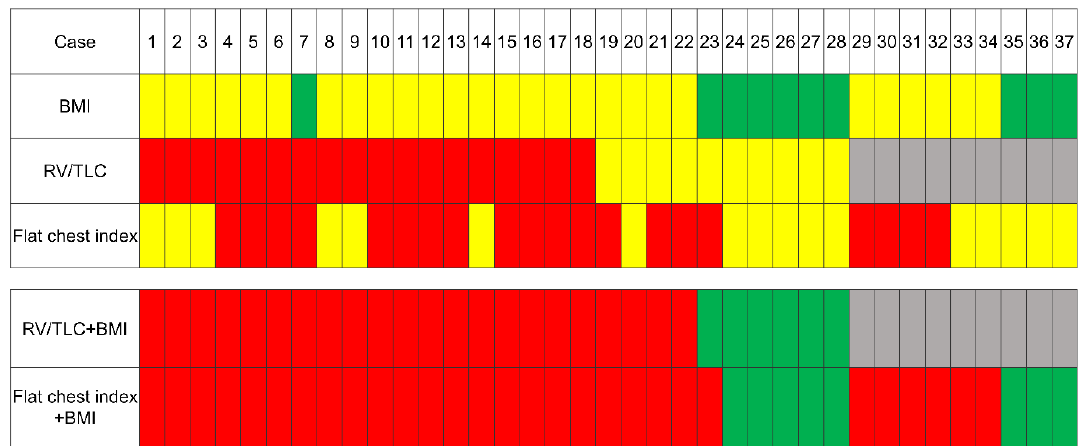
Figure 5. A summary of the results determined according to the cut-off values of each physiological parameter in IPPFE patients. ( █ ) represents the results that were directly related to the diagnosis: a percentage of the predicted values of residual volume / total lung capacity (RV / TLC %pred.) ≥ 115%